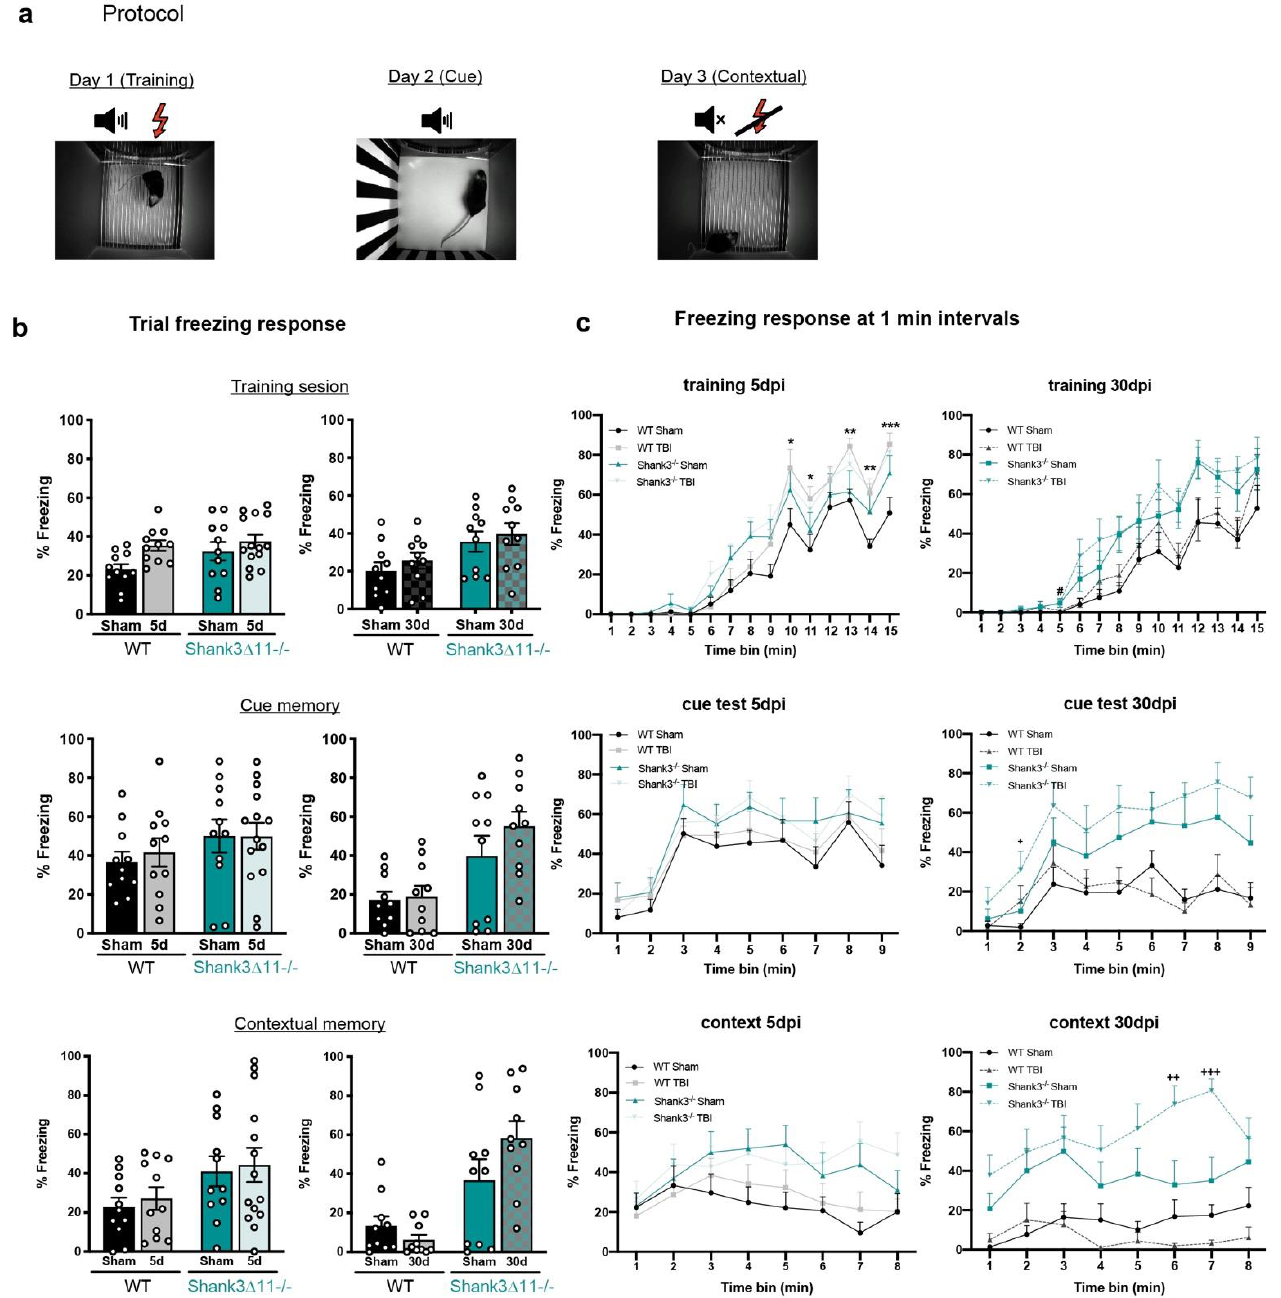
Figure 7. Trace fear conditioning memory was slightly affected in both genotypes following mTBI. ( a ) Depiction of the protocol for the training, auditory or cued memory and contextual fear conditioning test sessions after 5 d and 30 d of mTBI. ( b ) Percentage of the time spent freezing during each whole trial. N = 10–14. Data are shown as mean ± SEM. Datasets were analyzed using two-way ANOVA (genotype × mTBI intervention), and Bonferroni’s post hoc comparison test was performed. [Training session at 5 d: genotype F(1, 43) = 2.723, p = 0.1062; mTBI intervention F(1, 43) = 6.122, p = 0.0174; interaction genotype × mTBI: F(1, 43) = 1.058, p = 0.3093. Training session at 30 d: genotype F(1, 36) = 8.862, p = 0.0052; mTBI intervention F(1, 36) = 0.8784, p = 0.3549; interaction genotype × mTBI: F(1, 36) = 0.1934, p = 0.8902]. [Cue session at 5 d: genotype F(1, 43) = 2.317, p = 0.1353; mTBI intervention F(1, 43) = 0.1131, p = 0.7383; interaction genotype × mTBI: F(1, 43) = 0.1293, p = 0.7209. Cue session at 30 d: genotype F(1, 36) = 16.38, p = 0.0003; mTBI intervention F(1, 36) = 1.353, p = 0.2525; interaction genotype × mTBI: F(1, 36) = 0.8815, p = 0.3541]. [Contextual session at 5 d: genotype F(1, 43) = 5.895, p = 0.0194; mTBI intervention F(1, 36) = 0.2757, p = 0.6022; interaction genotype × mTBI: F(1, 43) =